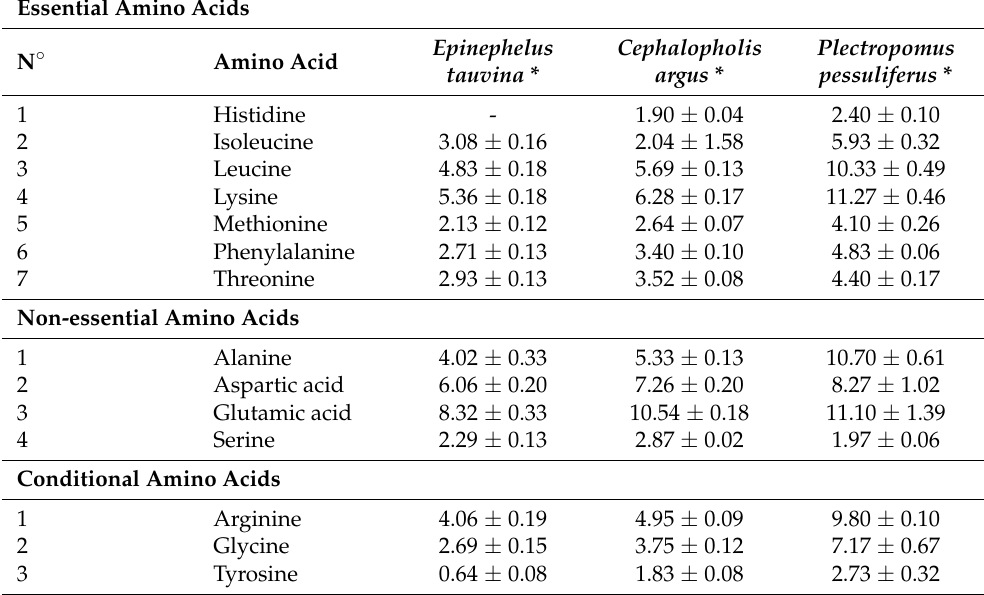
Table 4. Amino acid concentrations in fish samples (g/100